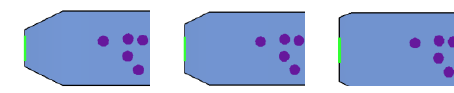
Figure 5. Change trapezoidal export while keep angle quantitative